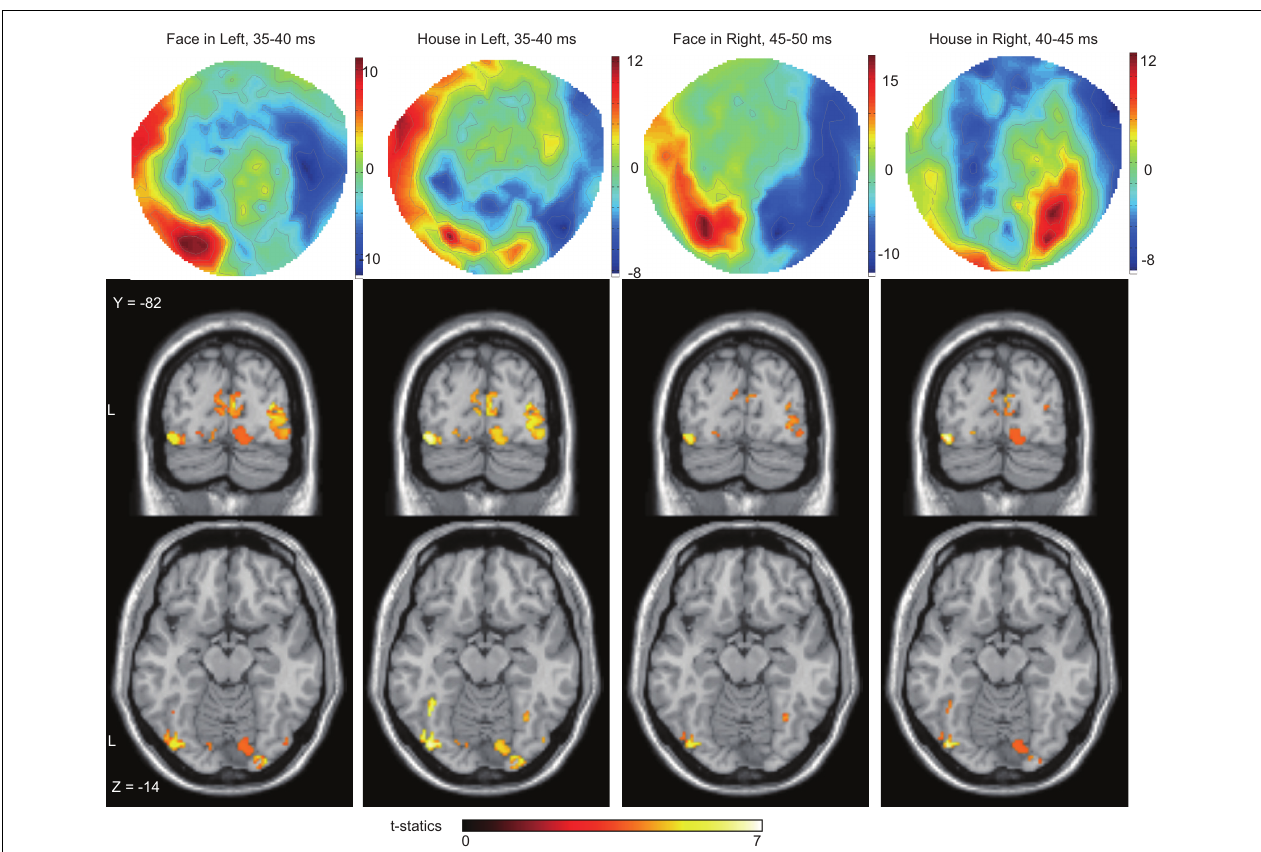
FIGURE 5 | Averaged contour maps across 18 subjects and statistical parametric maps of estimated source locations of ERFs for group-level analysis (between subjects), superimposed on a standard brain image, broken down by stimulus form and display quadrant. Source estimation was performed using MSP during peak time window. Contour maps: Red areas represent outflow of magnetic fields and blue areas their inflow, hence the proximity of the two